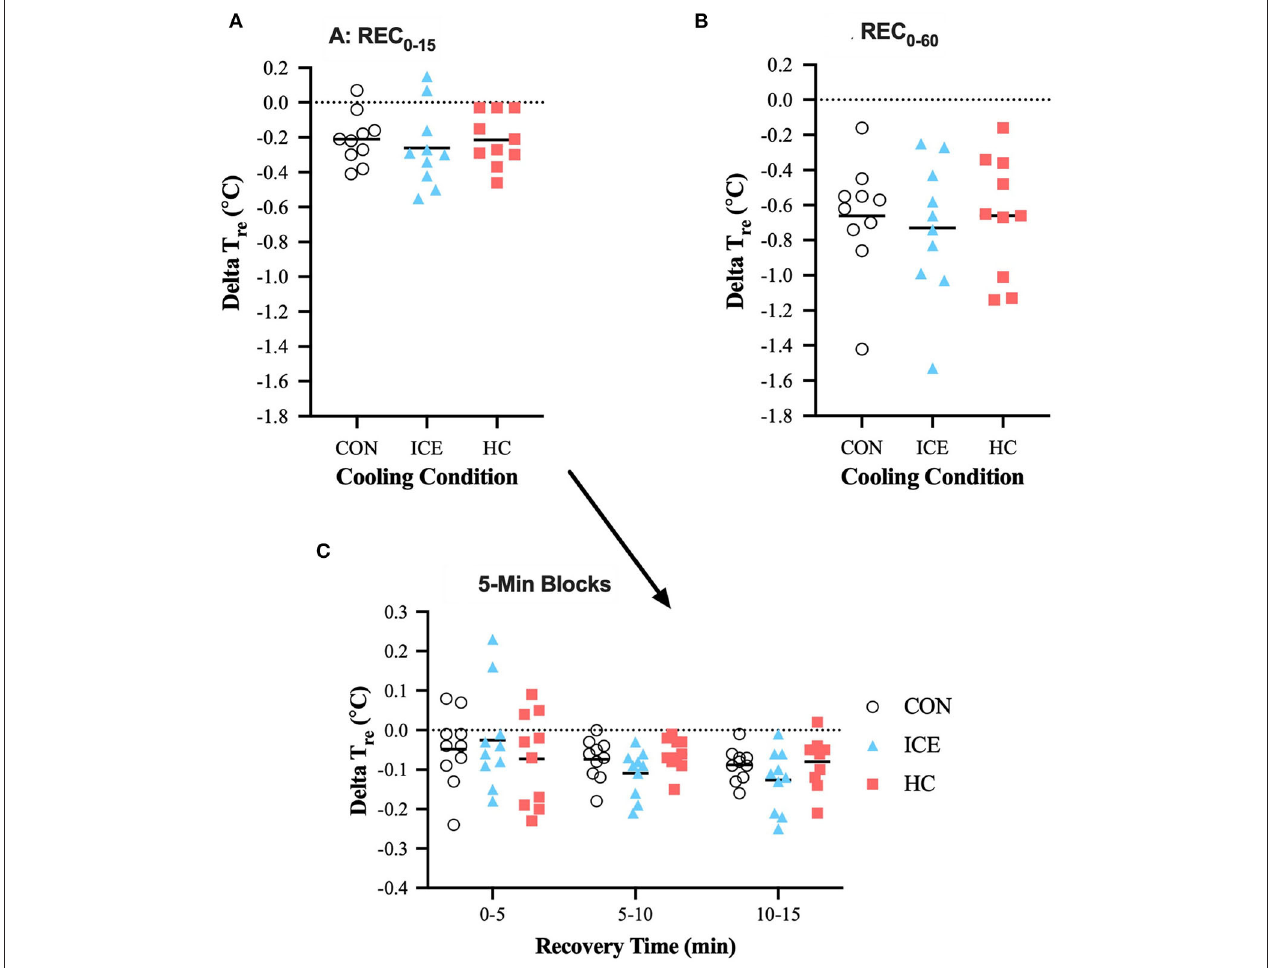
FIGURE 2 | Mean (bar) and individual delta rectal temperature ( T re ) during REC 0 − 15 (A) , REC 0 − 60 (B), and 5-min blocks during REC 0 − 15 (C) when using ice vest (ICE), single-hand cooling (HC), and non-cooled control (CON) during heated exercise